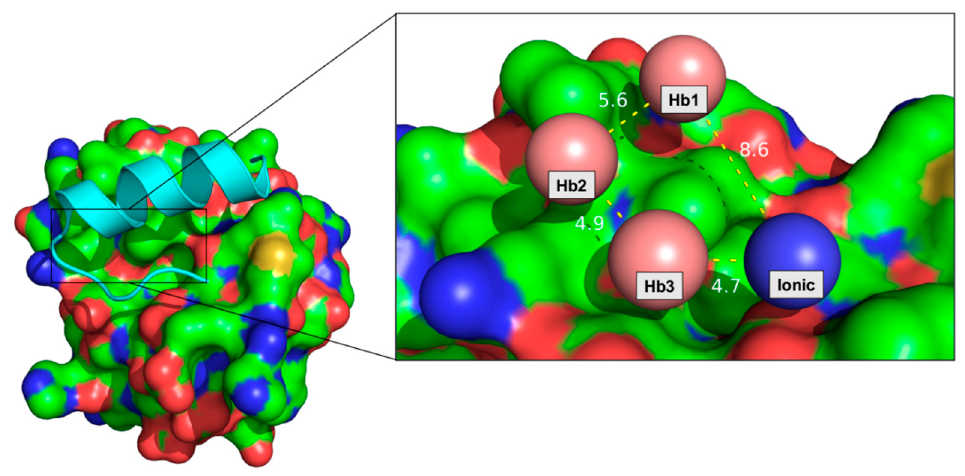
Figure 1. Crystal structure of Snu66-Hub1 (PDB ID: 3PLU). Snu66 is displayed as cyan cartoons while Hub1 as a colored surface (carbon: green, sulphur: yellow, oxygen: red, nitrogen: blue). The enlargement view shows the pharmacophoric model consisting of three hydrophobic (salmon spheres) and one ionic features (blue sphere). Distances between the centroids are illustrated as yellow dotted lines. Table 5. Summary of the binding cooperativity analysis including the molecular interaction count and total score for each individual peptide.